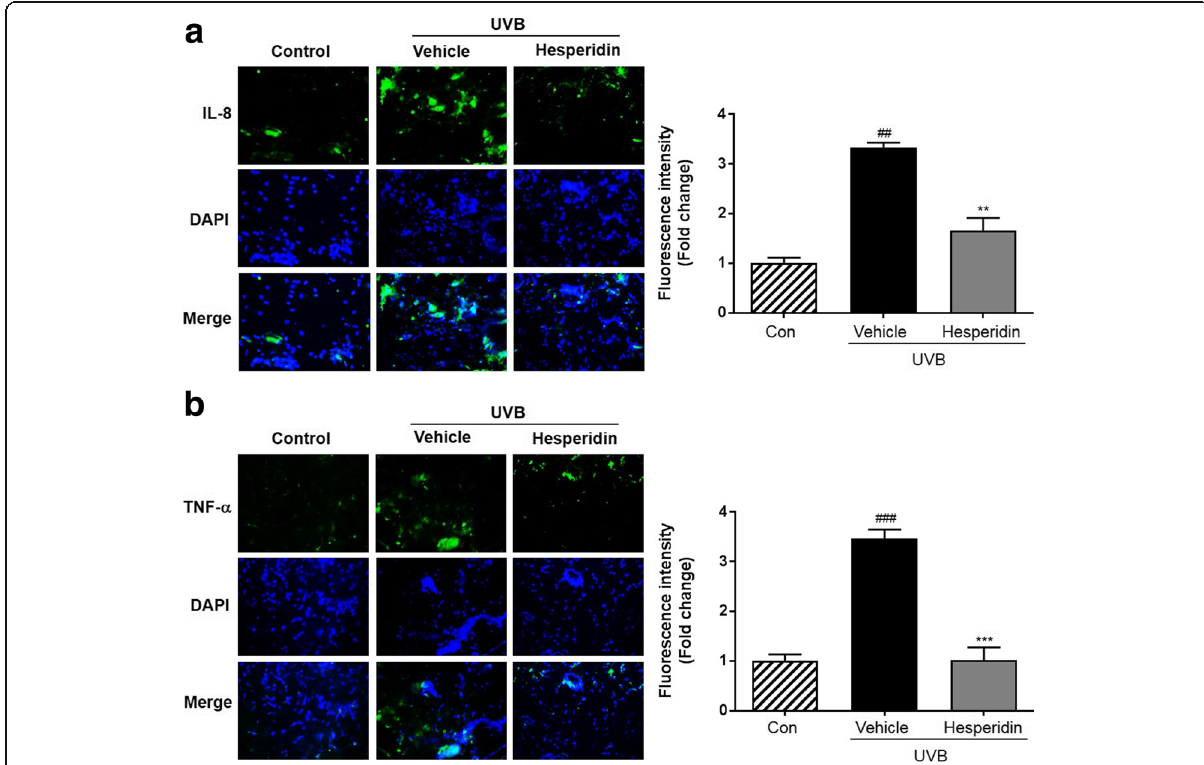
Fig. 5 Images of immunohistochemically-stained skin tissue. Immunofluorescence study was carried out using ( a ) IL-8 and ( b ) TNF- α antibodies. Blue staining represents nucleus. Quantitative analysis of fluorescence intensity was performed by Image J software. ## P < 0.01, and ### P < 0.001 significant difference from control and ** P < 0.01, and *** P < 0.001 Significant difference from UVB/vehicle